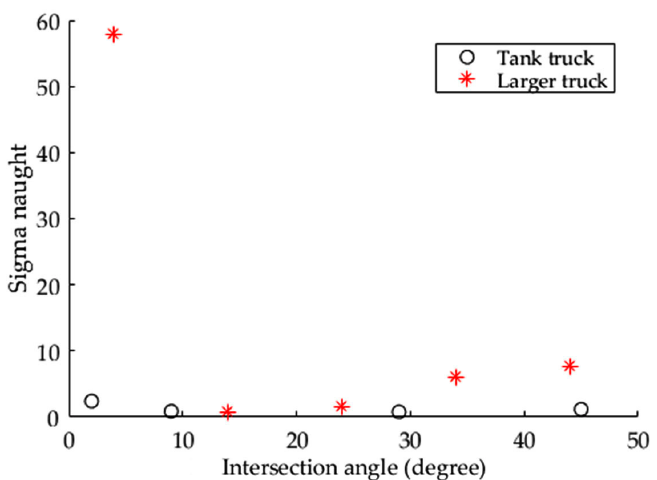
Figure 8. A comparison of (cid:2026) (cid:2868) between cylindrical-shaped tank trucks in Experiment IV and parallelepiped-shaped larger trucks in Experiment III. parallelepiped-shaped larger trucks in Experiment